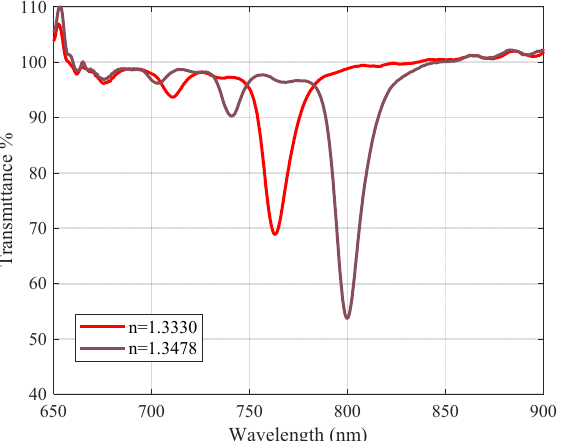
Figure 1. Refractometric characterization curve for a DLUWT with a thickness of 8 nm for the Al layer and 47 nm for the TiO 2 layer. This corresponds to the employed DLUWT before the GO deposit. We show the variation corresponding to two di ff erent refractive indices of the surrounding medium.